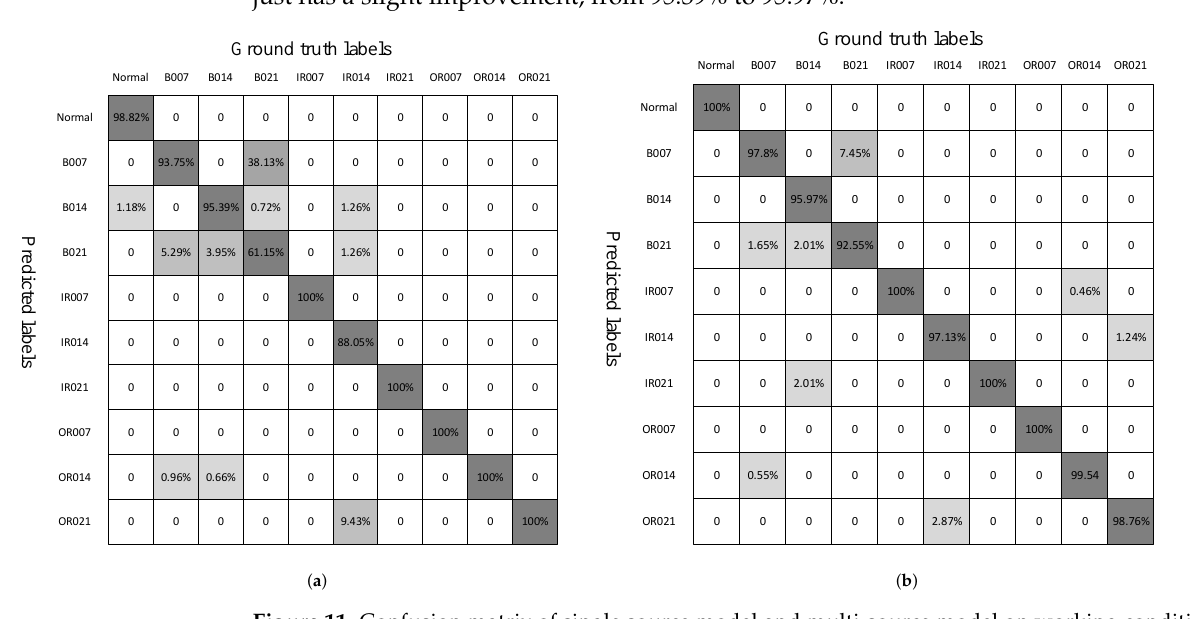
Figure 11. Confusion matrix of single source model and multi-source model on working condition 2. (SNR = − 4). ( a ) DANN+MK-MMD; ( b ) MCDANN.